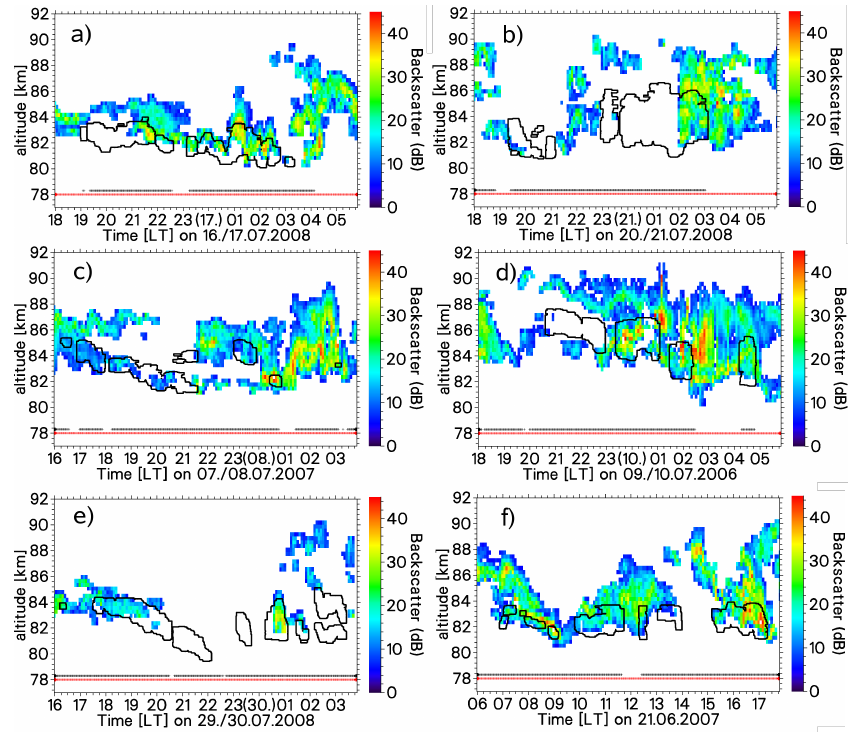
Fig. 2. Examples of joint PMSE (color, limited to > 5dB) and NLC (contour, limited to β> ∆ β ) observations. Measurement times are indicated by red crosses for radar and in black crosses for lidar.